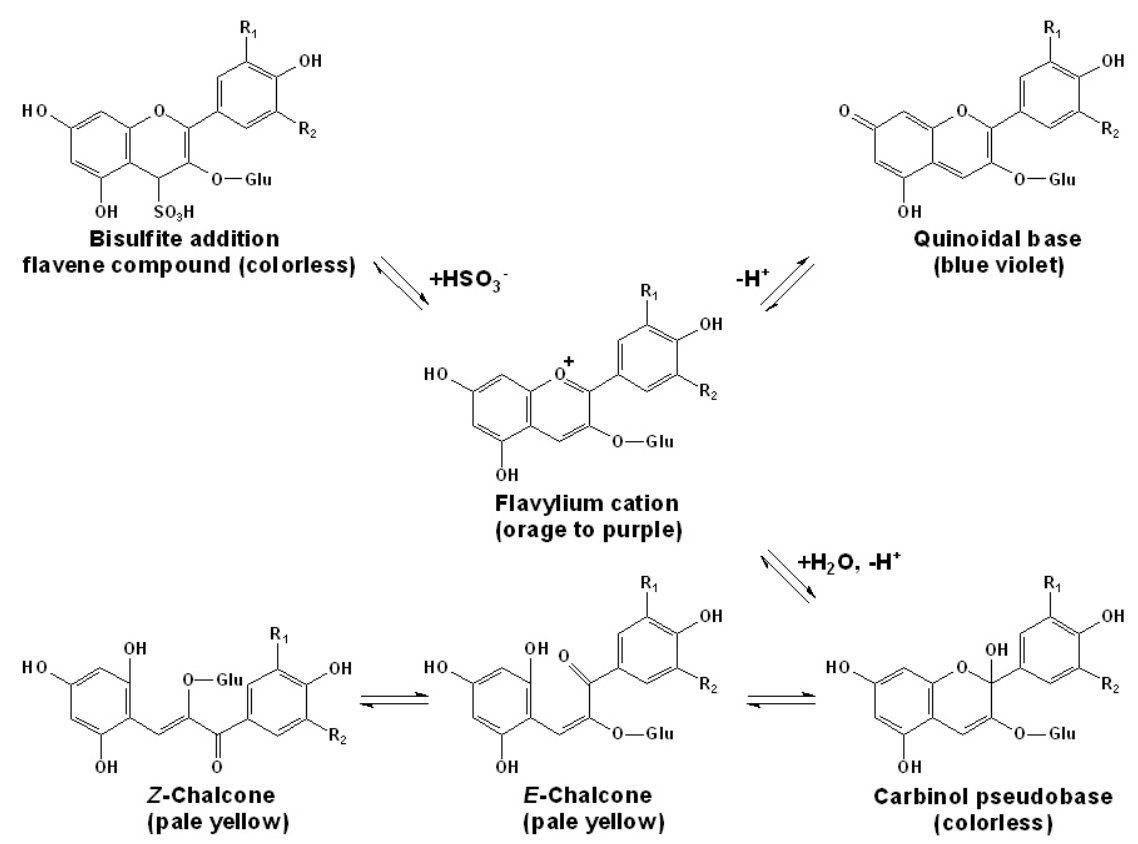
Figure 3. The pH-dependant equilibria among the various structural forms of anthocyanins in red wines [12,75,76,93–97]. The groups of R